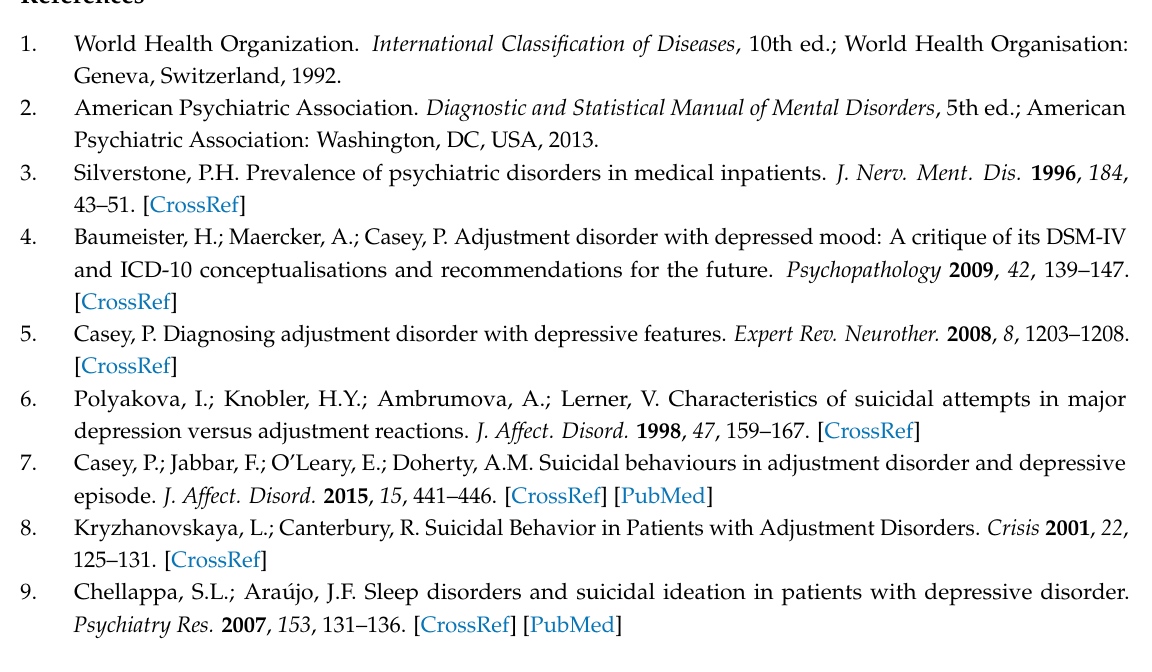
s1, Table S1: Demographic and clinical characteristics of patients divided by